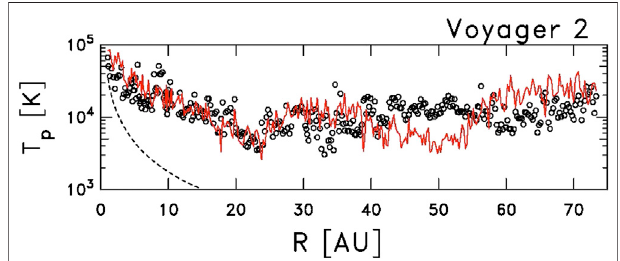
FIGURE 1 | Average solar wind proton temperature as seen by Voyager 2 (circles) and prediction of transport theory (red curve). Dashed line represents predicted proton temperature derived assuming adiabatic expansion from 1 AU (Taken from Smith et al.